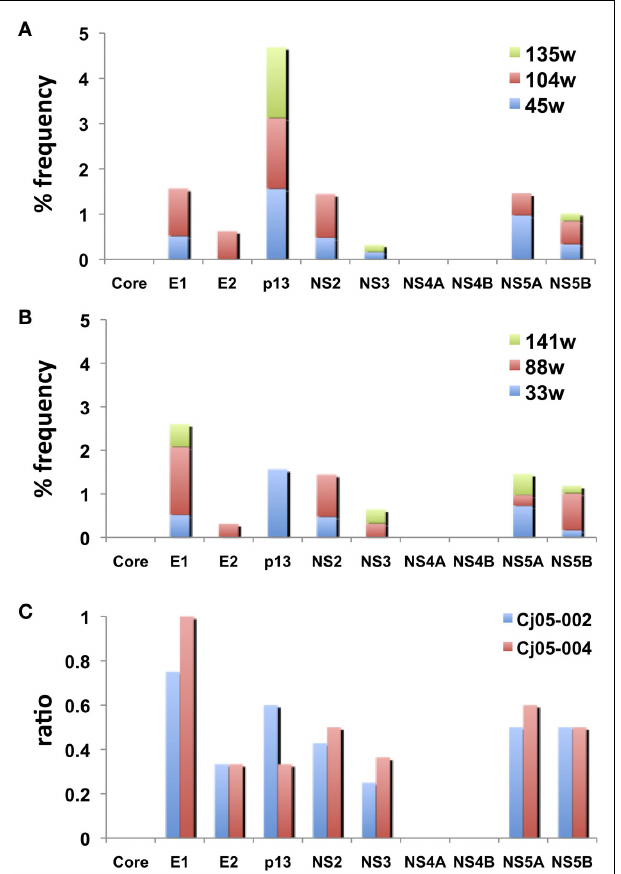
FIGURE 5 |The frequency of the non-synonymous mutations in the viral genome sequences amplified from plasma of the marmosets persistently infected with GBV-B. (A,B) The accumulated frequency of the non-synonymous mutations per total amino acid numbers of each viral protein at multiple time points are illustrated [ (A) at weeks 45, 104, and 135 in Cj05-002; (B) weeks 33, 88, and 141 in Cj05-004].To compare the frequency between the two marmosets, the data at week 229 p.i. in Cj05-004 are omitted. (C) The ratio of the non-synonymous mutations per total numbers of nucleotide mutations identified at weeks 45, 104, and 135 in Cj05-002 and at weeks 33, 88, and 141 in Cj05-004 in each viral gene.To compare the frequency between the two marmosets, the data at week 229 p.i. in Cj05-004 are omitted.